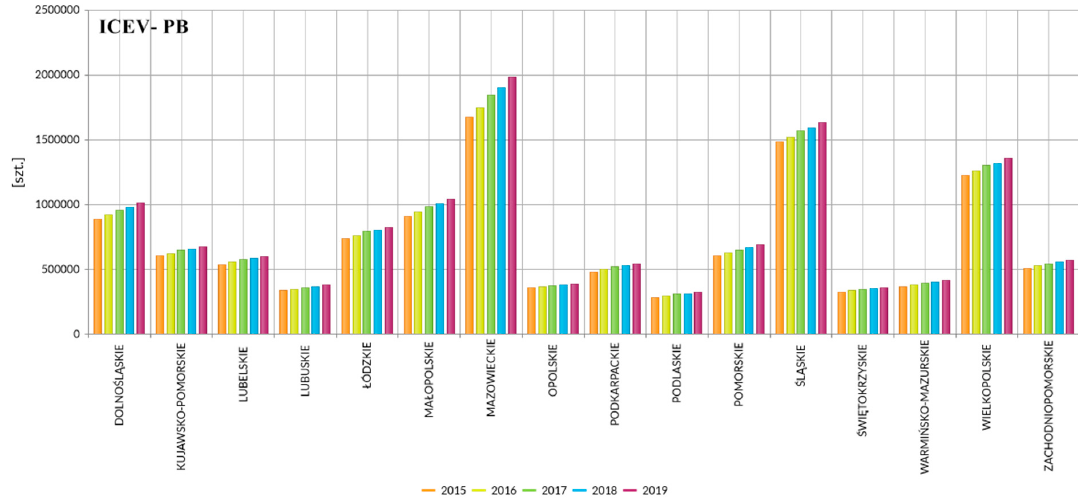
Figure 2. Number of ICEV petrol vehicles.